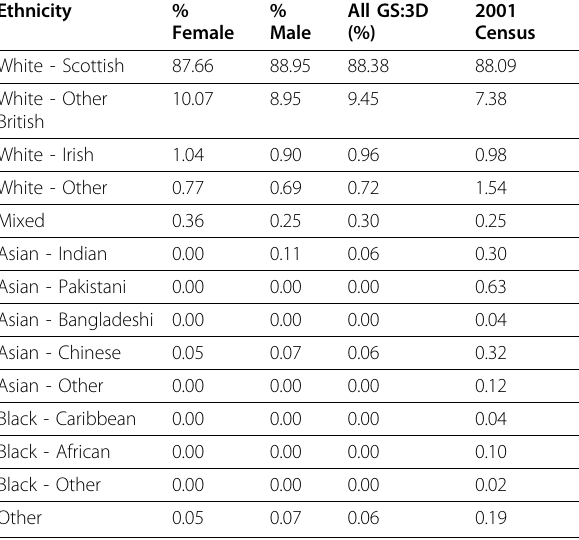
Table 1 Recorded ethnicity of GS:3D participants Ethnicity